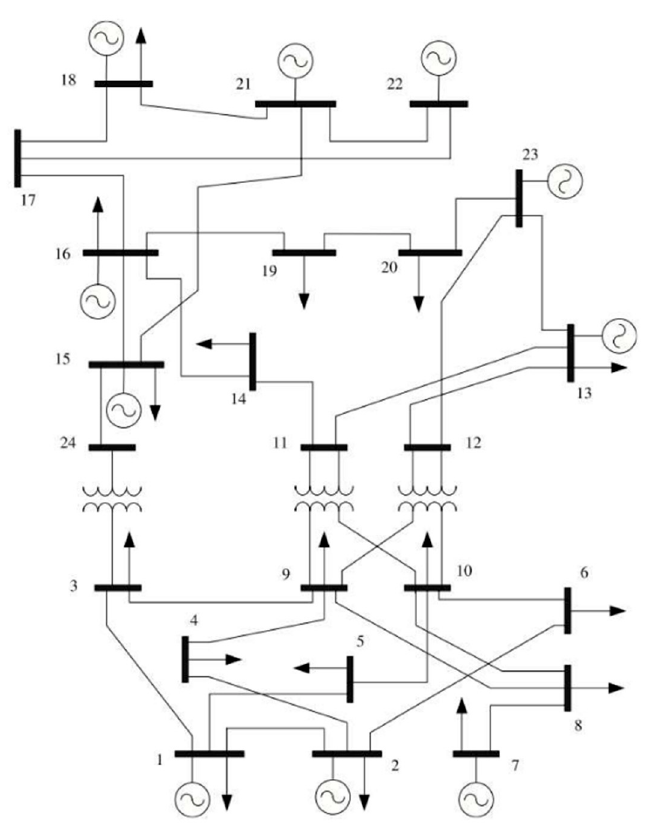
Figure 3. The structure diagram of IEEE 24-bus system.